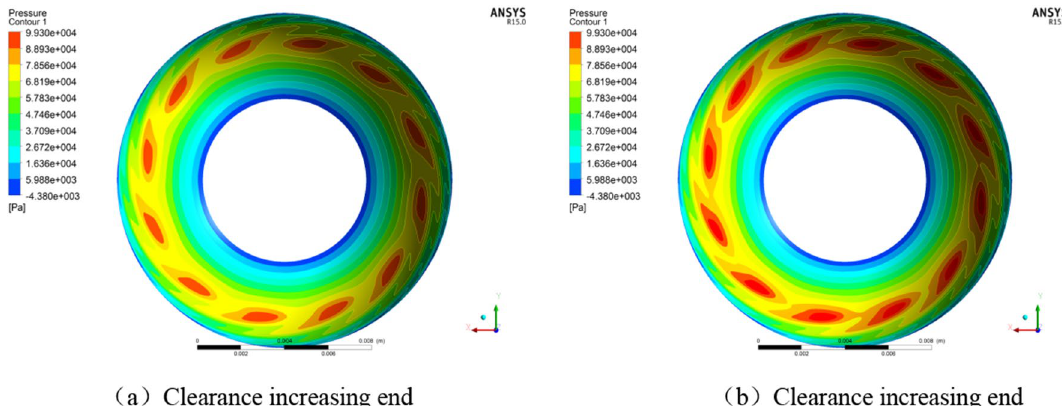
Figure 7. Pressure distribution of gas film under different axial displacements.